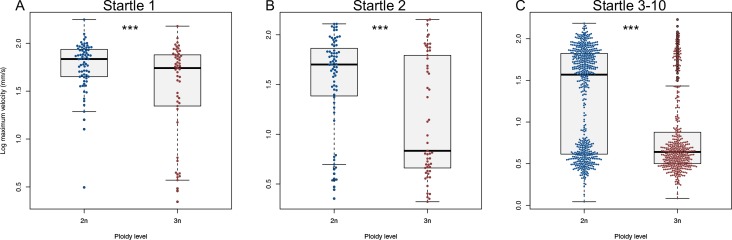
Startle response of diploid and triploid larvae.A) Swimming velocity of diploid and triploid larvae at the first startle stimulus. B) Swimming velocity of diploid and triploid larvae at the second startle stimulus. C) Swimming velocity of diploid and triploid larvae at the third to tenth startle stimulus. ANOVA, *** p < 0.001, n = 124.